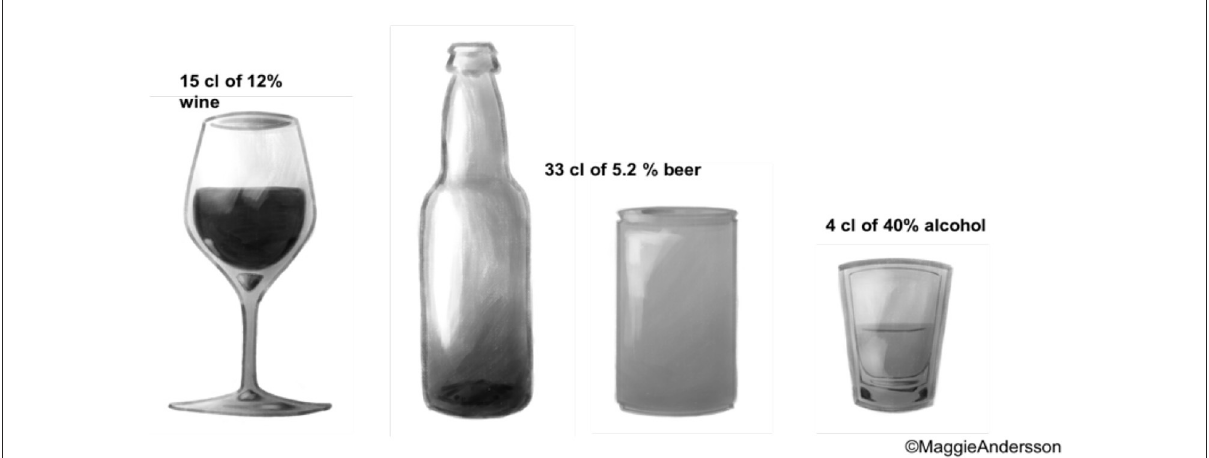
FIGURE1 Examples of one unit of alcohol (12–14g). One can/bottle of 5.2% beer; 33cl/12fl oz = 13.5g alcohol, one glass of 12% wine; 15cl/5fl oz = 14g alcohol, one shot of 40% hard liquor; 4 cl/1.5 fl oz% = 12.6g alcohol. Reproduced with permission from Maggie Andersson, private